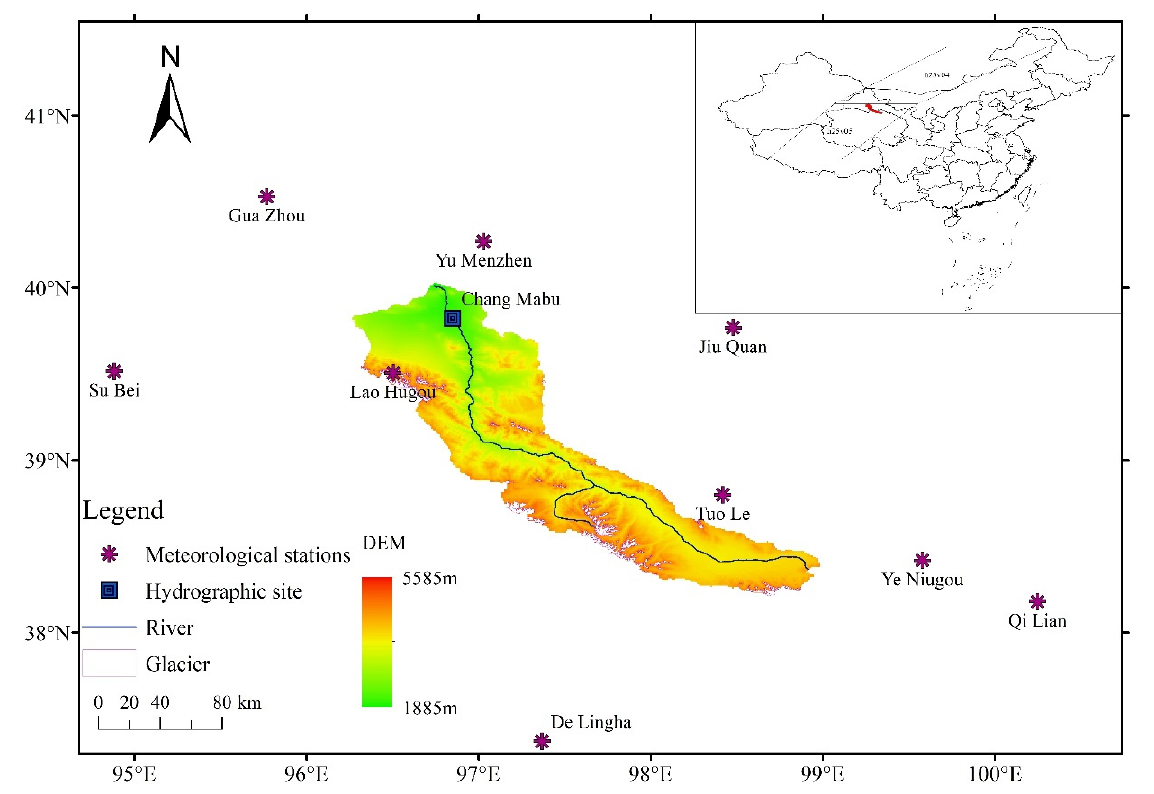
Figure 1. Location and terrain of the upper reaches of the Shule River Basin and weather stations.